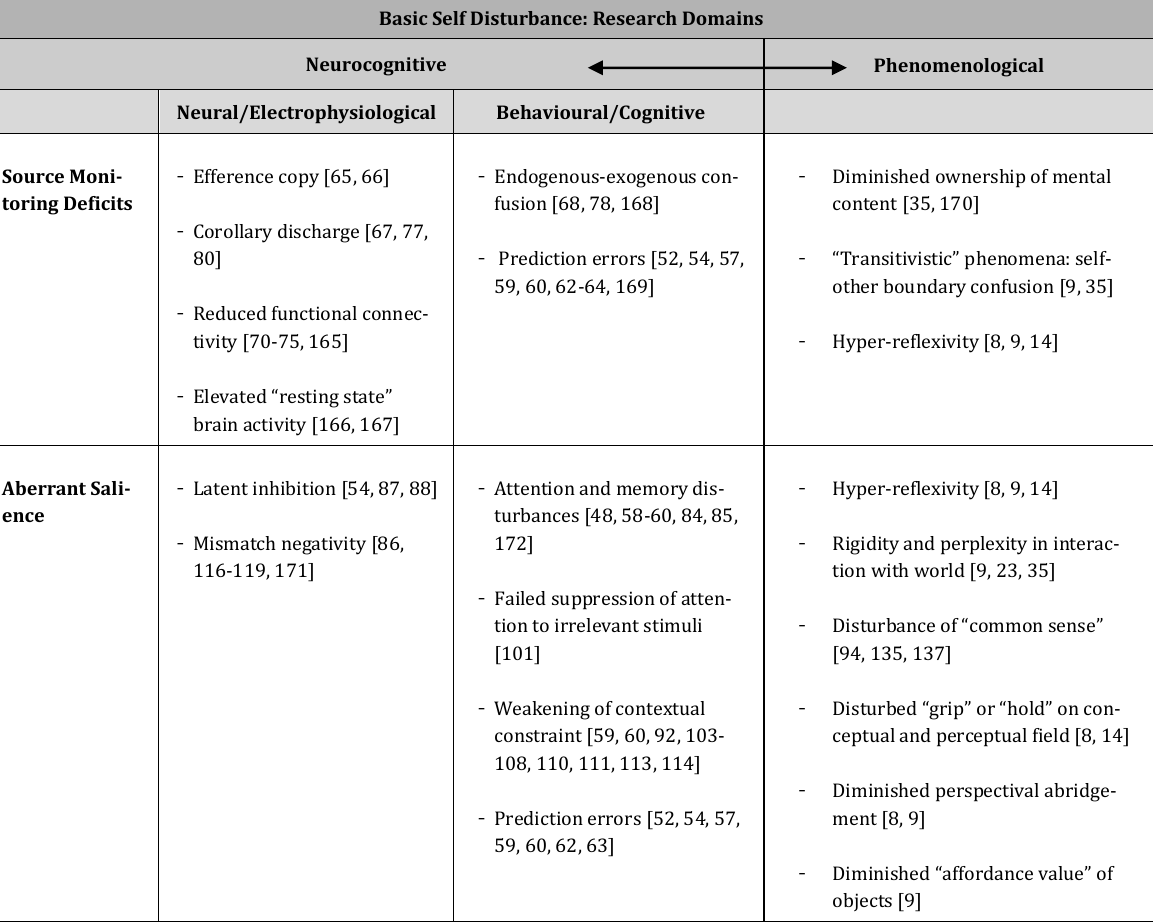
Table 1 Proposed neurocognitive and phenomenological correlates indicative of basic self-disturbance in